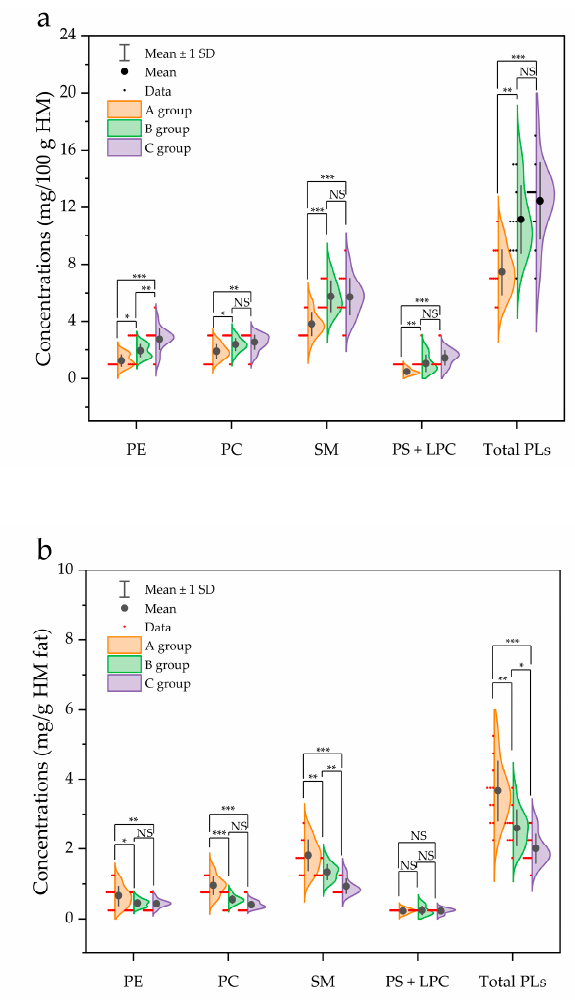
Figure 4. Comparison of the concentrations of phospholipid species in human milk. ( a ) Presented as mg per 100 g of human milk (HM), and ( b ) normalized for 1 g of HM fat in different groups (A group, n = 11; B group, n = 10; C group, n = 12. One sample in group B was omitted due to insufficient amount for analysis). *, **, and *** represent a significance of difference at p < 0.05, p < 0.01, and p < 0.001, respectively. NS represents non-significant difference ( p > 0.05). PE, phosphatidylethanolamine; PC, phosphatidylcholine; SM, sphingomyelin; PS, phosphatidylserine; LPC, lysophosphatidylcholine; total PLs, sum of PE, PC, SM, PS and LPC.